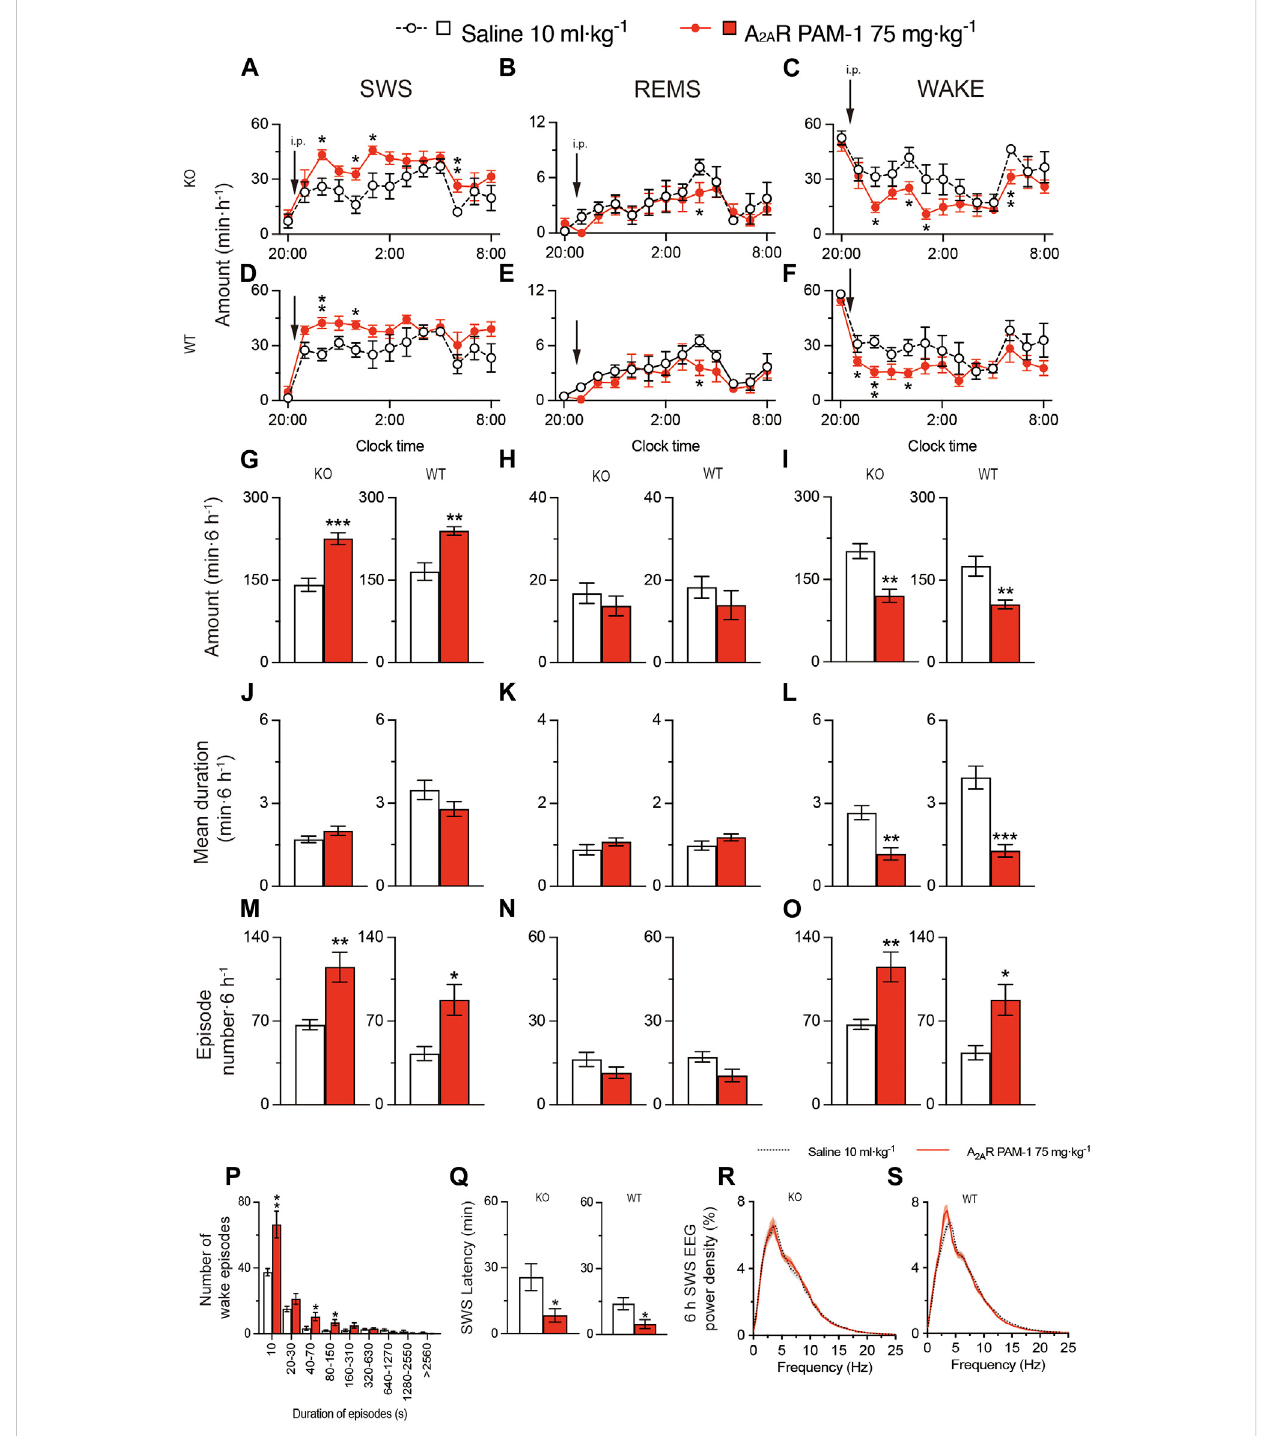
FIGURE 7 Intraperitoneal injection of A 2A RPAM-1 induces sleep in a mouse model of schizophrenia. (A – O) Time course (A – F) , total amount (G – I) , mean duration (J – L) , and episode number (M – O) of SWS, REMS, and wakefulness in MAP6 (STOP) knockout (KO) and wild-type (WT) mice after administering saline or A 2A RPAM-1. (P) Wake episode spectrum in MAP6 (STOP) KO mice. (Q) Latency to sleep onset in MAP6 (STOP) KO and WT mice after administering saline or A 2A RPAM-1. (R,S) EEG power density of SWS for 6 h after injecting saline or A 2A RPAM-1 into MAP6 (STOP)KO (Q) and WT (R) mice. Data (n = 6/group) are presented as mean ± SEM. Signi fi cance levels are indicated as * p < 0.05, ** p < 0.01, and *** p <